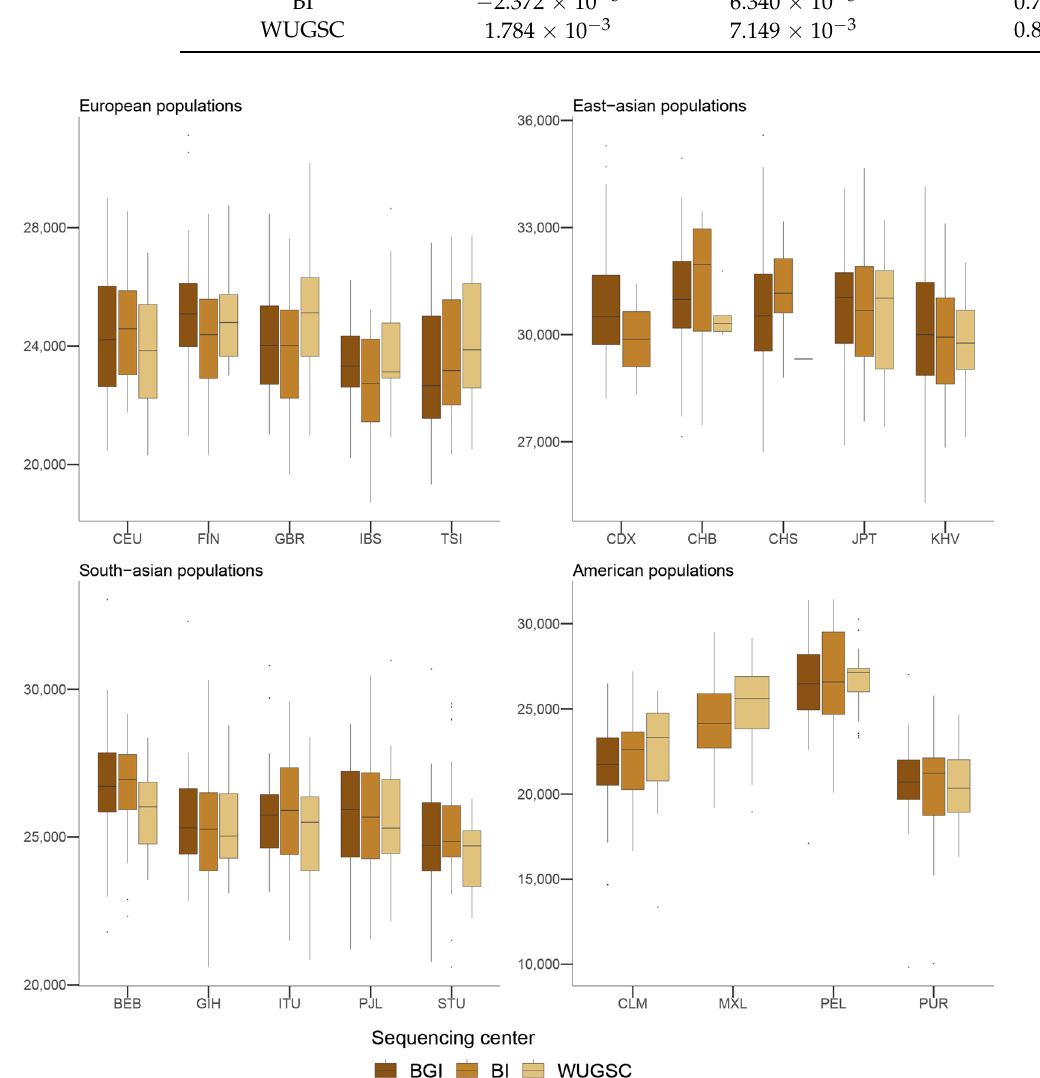
Figure 6. Number of introgressed alleles by sequencing center across continental groups and popu- lations . Each panel corresponds to a continental group. In the x-axis the name of the population is displayed; in the y -axis the number of introgressed alleles as defined by [4] is displayed. Acronyms are showed in Supplementary Materials Table S1.